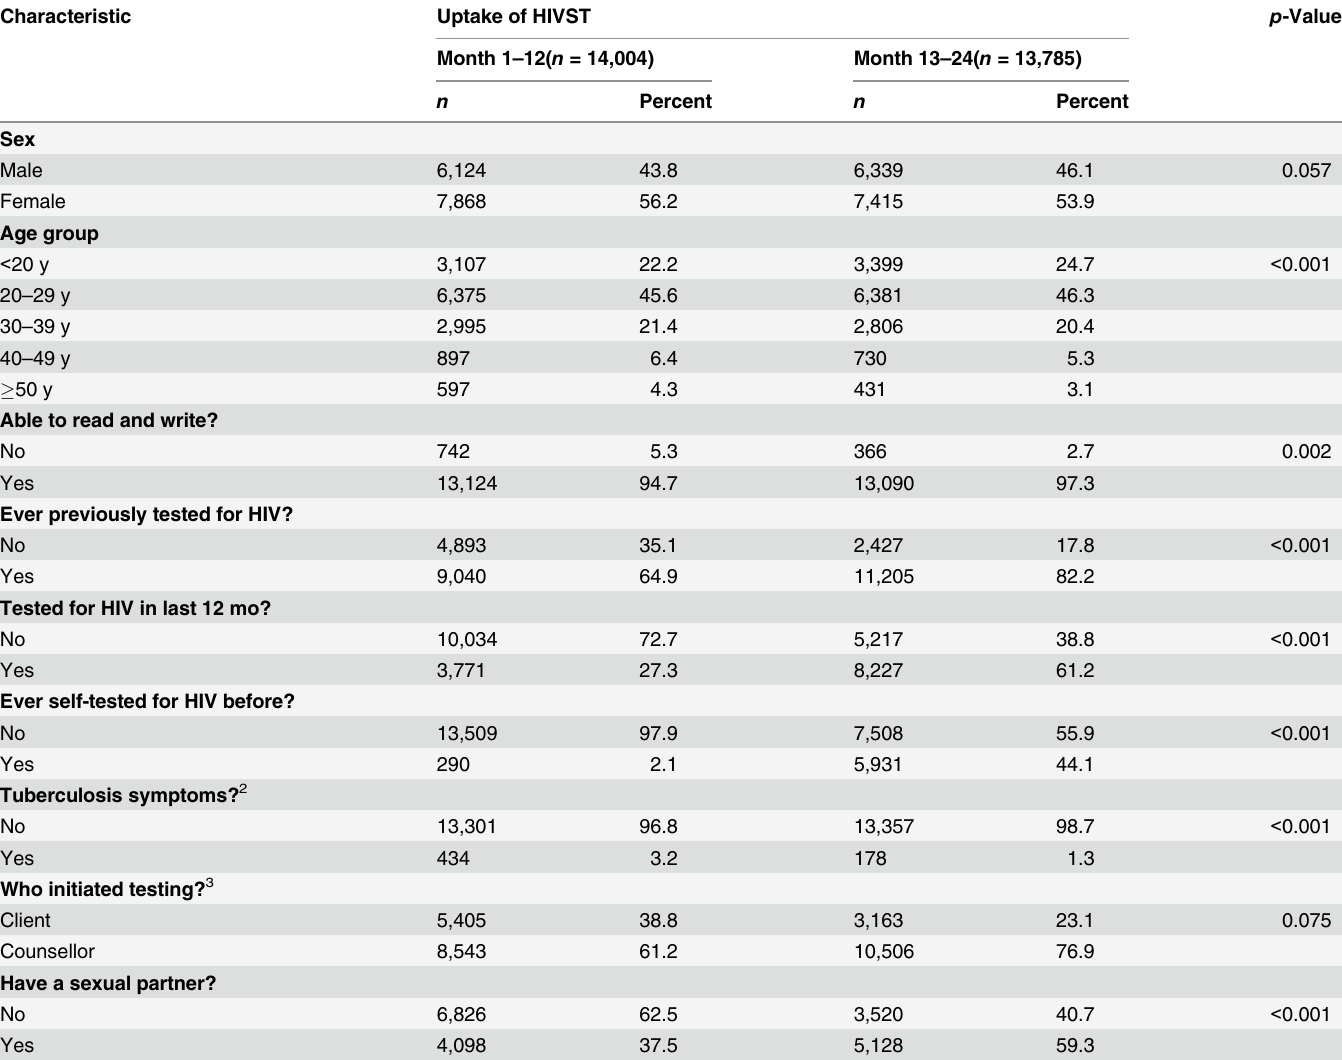
Table 1. Characteristics of HIV self-testing participants in the first and second years of HIV self-testing availability.